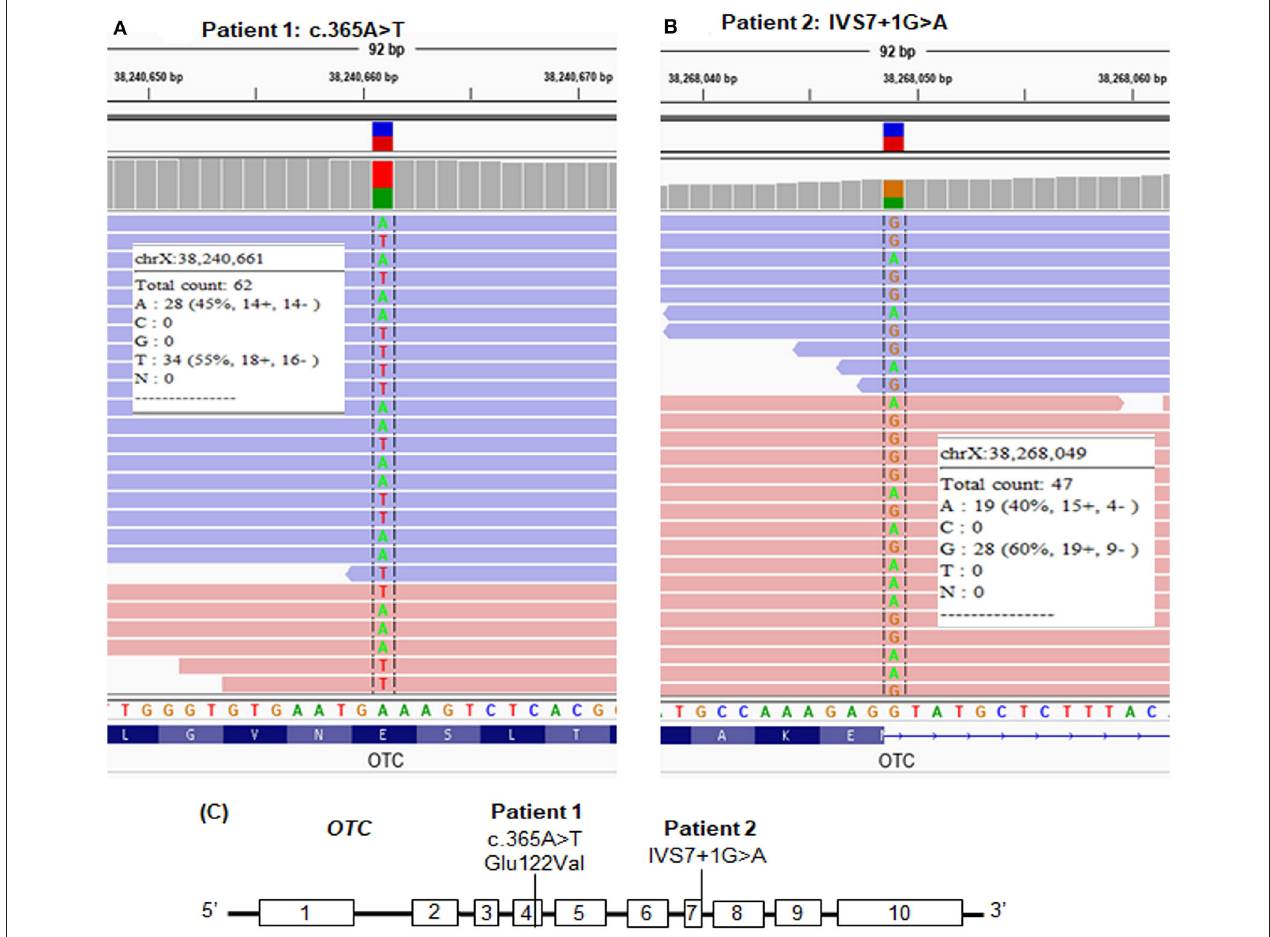
FIGURE 2 | Whole-exome sequencing (WES) paired-end reads are loaded in the IGV genome browser and are shown for each patient. (A) The heterozygous mutation, c.365A > T, in patient 1. (B) The heterozygous mutation, IVS7 + 1G > A, in patient 2. (C) Location of the point mutations in the OTC